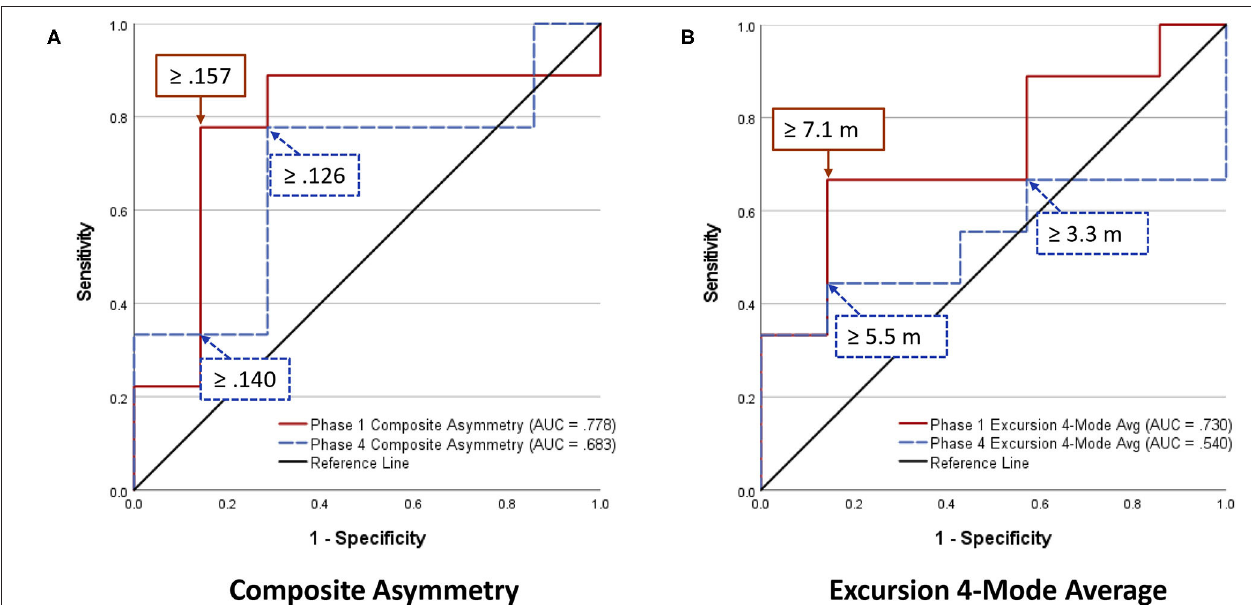
FIGURE 4 | Receiver operating characteristic curves identifying History of Sport-Related Concussion cases in early phase (red solid line; sessions 1–3) and late phase (blue dashed line; sessions 10–12) of 12-session whole-body reactive agility training program: (A) Composite Asymmetry (average for 4 task modes and 4 performance metrics), (B) Excursion (average for 4 task modes).